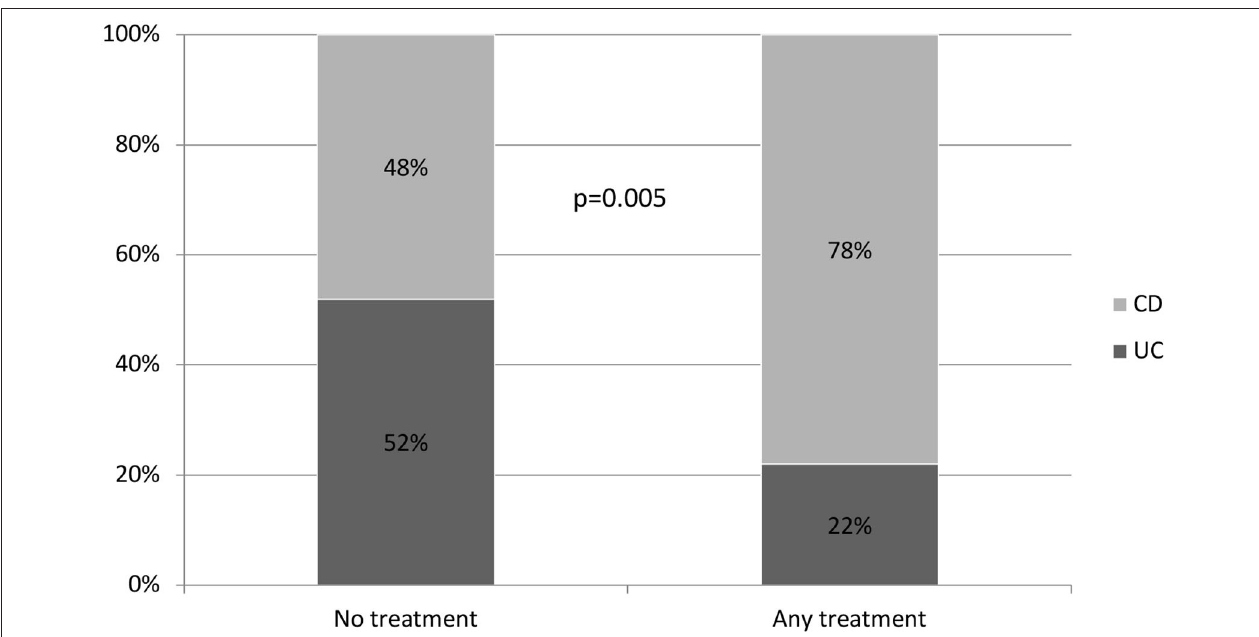
FIGURE 3 | Probability of NO treatment at all (No biological drug, surgery, or corticosteroids).